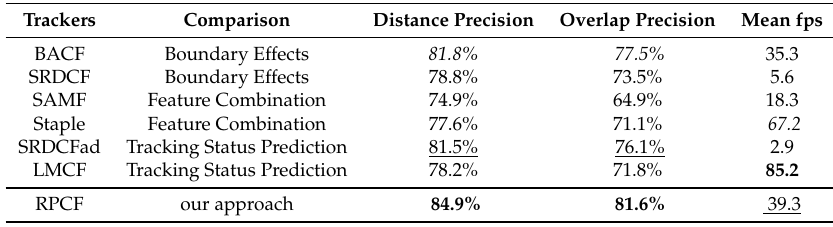
Table 1. Detail information about related trackers performance in OTB100. Boldface , italics and underline represent 1st, 2nd and 3rd respectively.